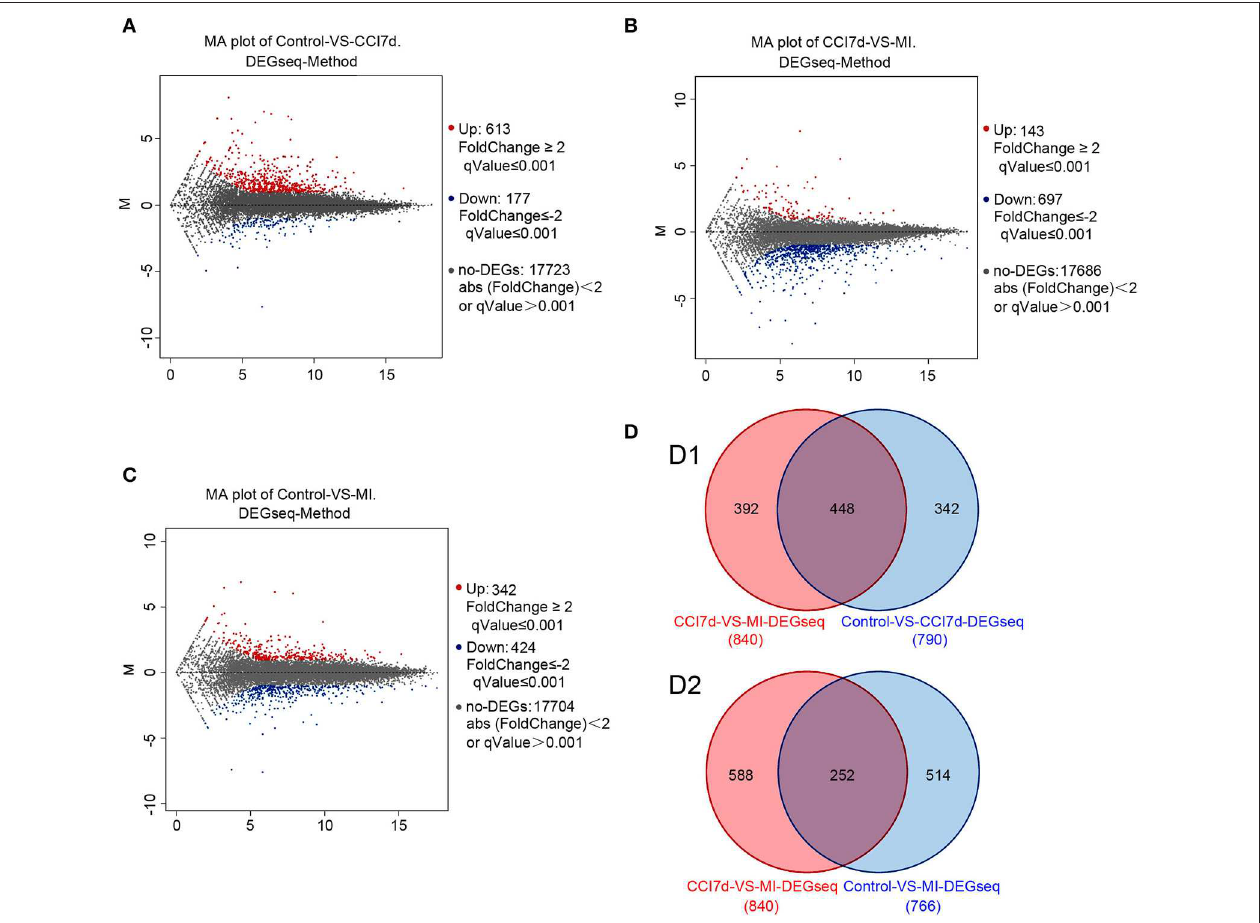
FIGURE 2 | The DEGs were identified. In (A–C) , red dots represent increased DEGs and blue dots represent decreased DEGs. In addition, gray dots represent non-DEGs. (A) MA plot for DEG analysis between sham and CCI groups. (B) MA plot of DEGs among the hippocampus between the CCI and minocycline-treated group. (C) MA plot of DEGs among the hippocampus between sham and minocycline-treated group. (D) Comparisons of the number and overlapping DEGs between different experimental groups (the Venn diagram of DEGs). (D1) Blue circle represents number of DEGs between sham and CCI group; red circle represents number of DEGs between CCI and minocycline-treated group; the overlapping area represents shared DEGs of two comparable groups. (D2) Blue circle represents number of DEGs between sham group and minocycline-treated group; red circle represents number of DEGs between CCI group and minocycline-treated group; the overlapping area represents shared DEGs of two comparable